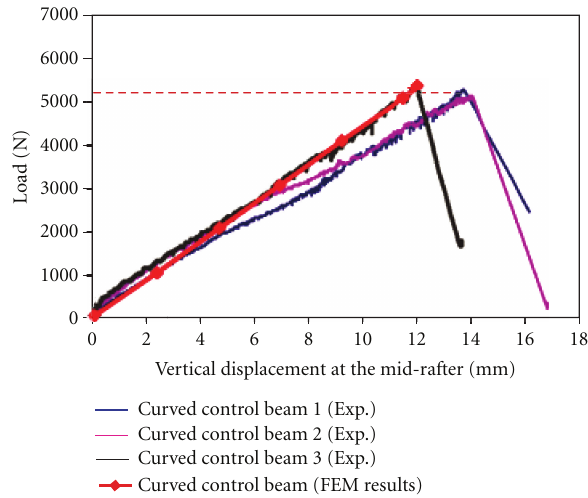
Curved control beam 3 (Exp.)